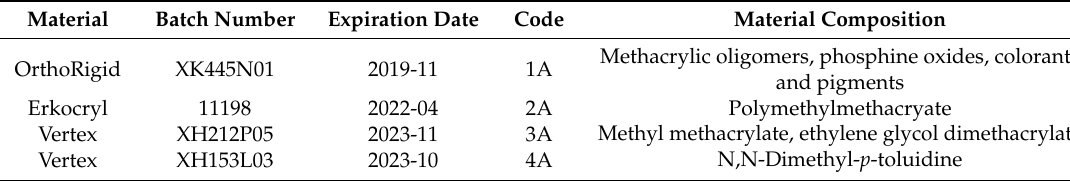
Figure 2. Preparation of the orthodontic plates by the methods of crushed dough and thermoforming: ( a ) applying a flow material 4A to a metal mold, ( b ) forming plates in a metal form, ( c ) plates